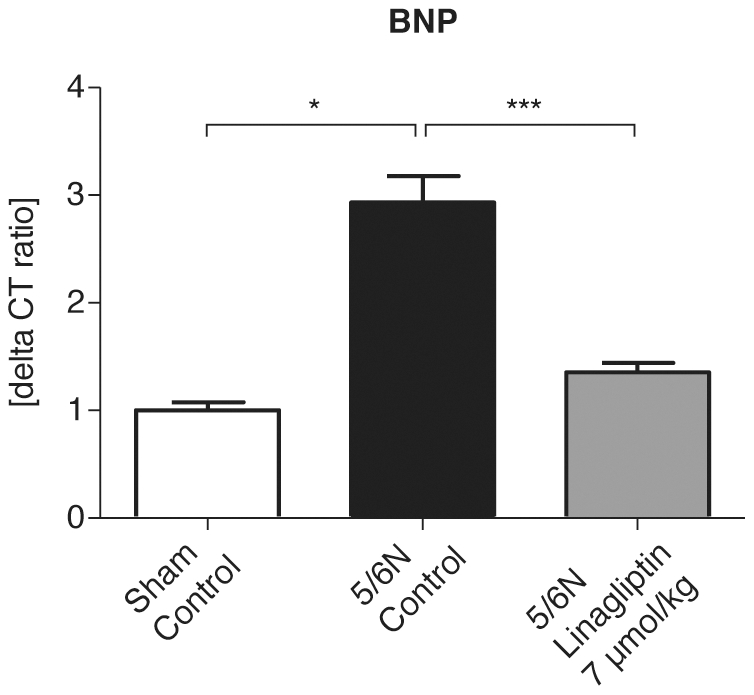
Experimental design.